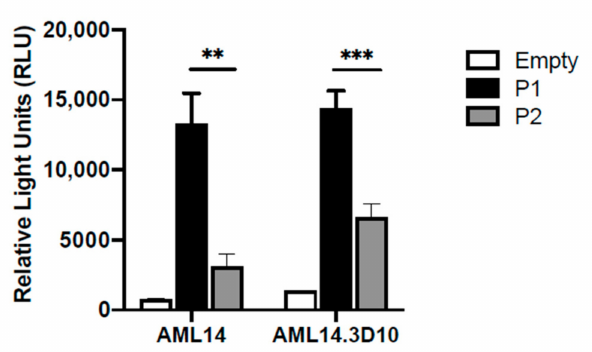
Figure 3. Differential IL-5RA P1 and P2 promoter activities in two eosinophilic cell lines. P1 and P2 are both constitutively active in the eosinophilic myeloblastic line AML14 and in the eosinophilic